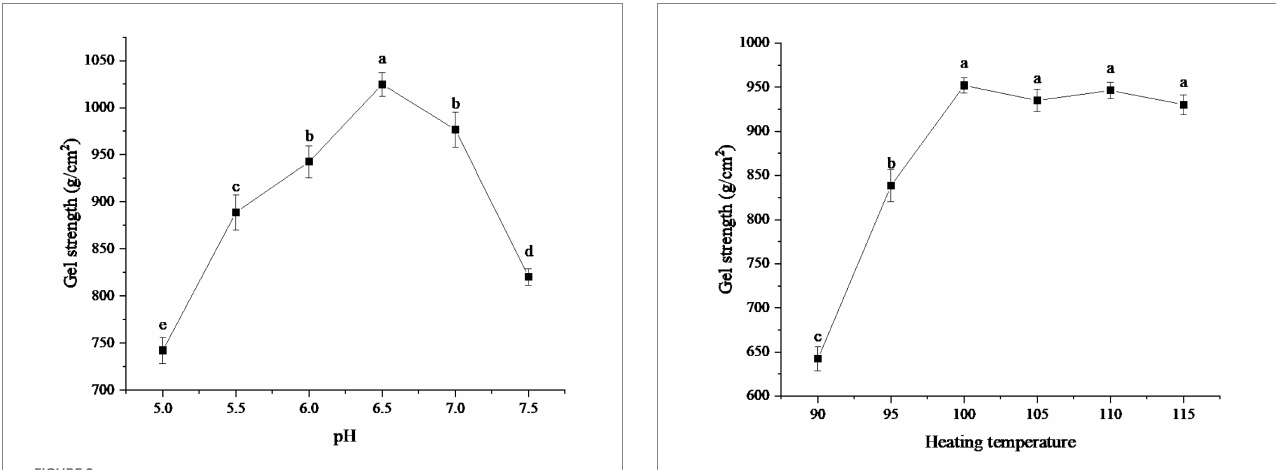
FIGURE 3 Effect of heating temperatures on gel strength of protein powder. Different lowercase letters express the significant differences ( p <